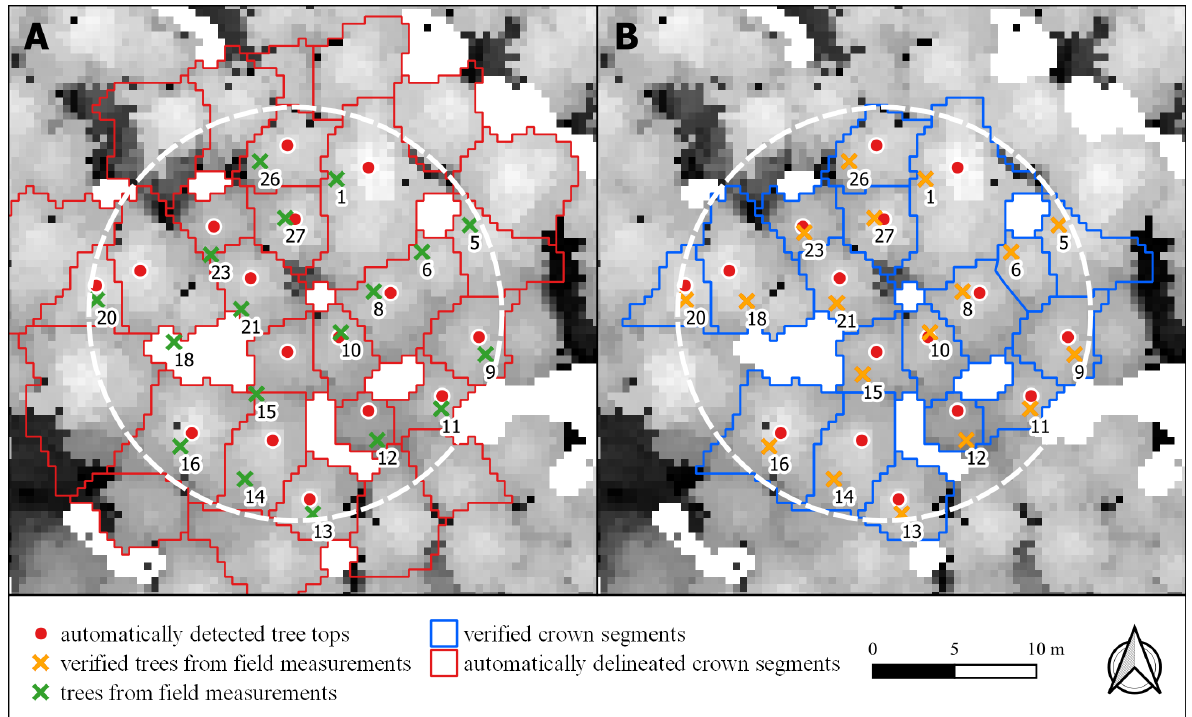
Figure 3. Comparison of field measurements of tree trunks with segments determined automatically ( A ) and after verification ( B ) in one of the sample plots with a radius of 12.62 m overlaid on Canopy Height Model